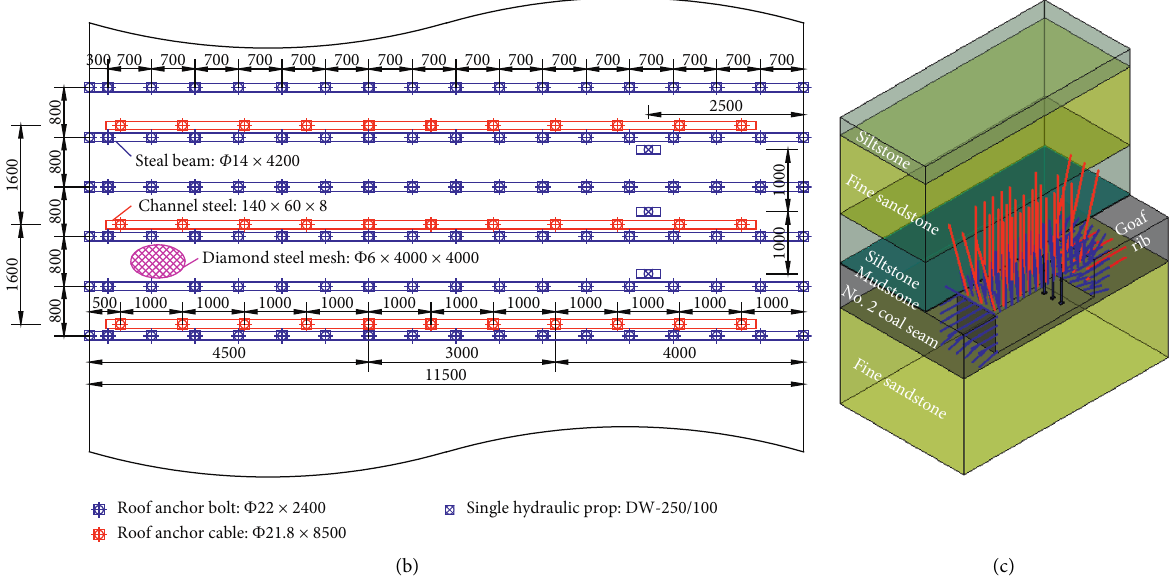
Figure 16: Combined support scheme in the 1128 open-off cut (unit: mm). (a) Supported section. (b) Roof support. (c) Three-dimensional support.